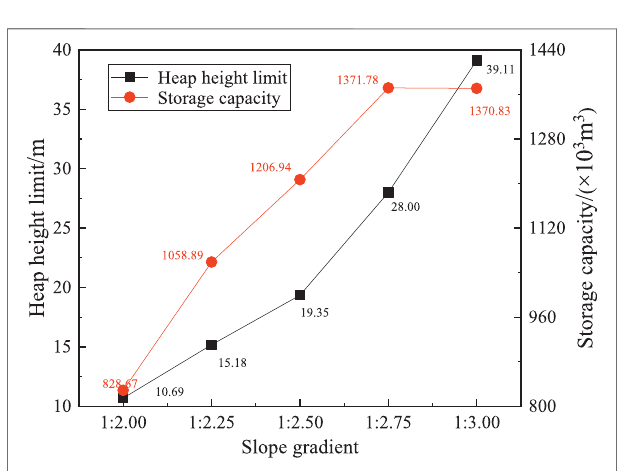
FIGURE 12 | Variations of heap height limit and storage capacity with slope gradient.